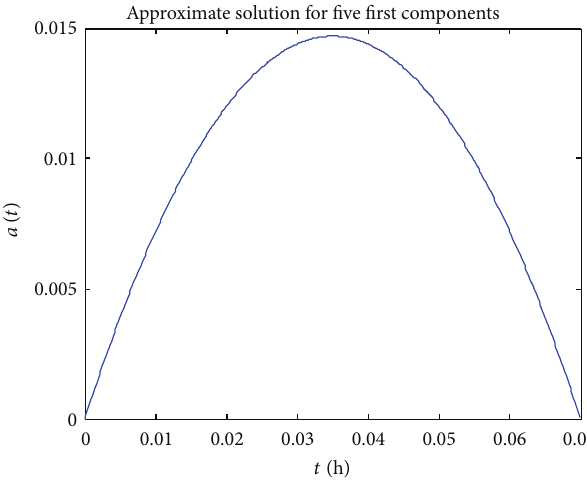
Figure 1: Approximate solution (26) of the governing differential equation in the elastic indentation phase for 𝛽 = 1.9 .